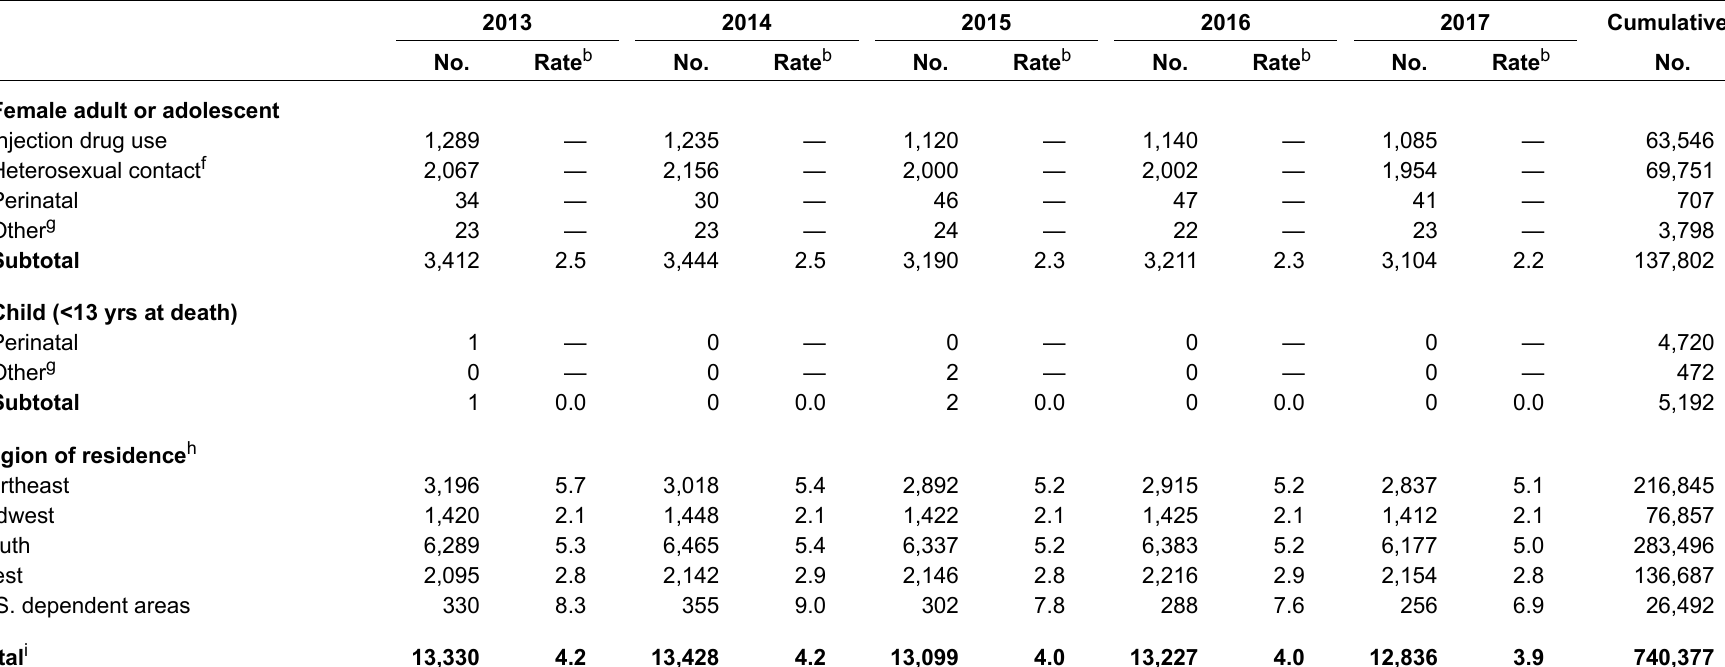
Table 19b. Deaths of persons with diagnosed HIV infection ever classified as stage 3 (AIDS), by year of death and selected characteristics, 2013–2017 and cumulative—United States and 6 dependent areas